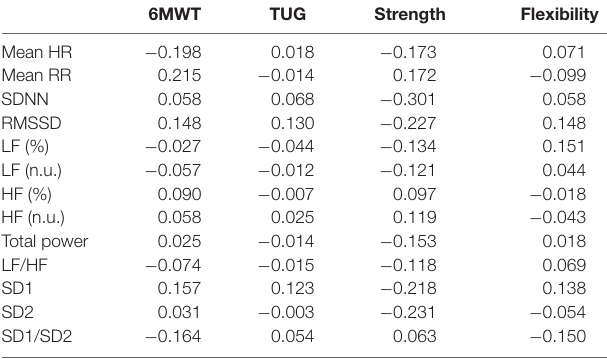
TABLE 3 | Correlation between HRV and physical parameters. 6MWT TUG Strength Flexibility